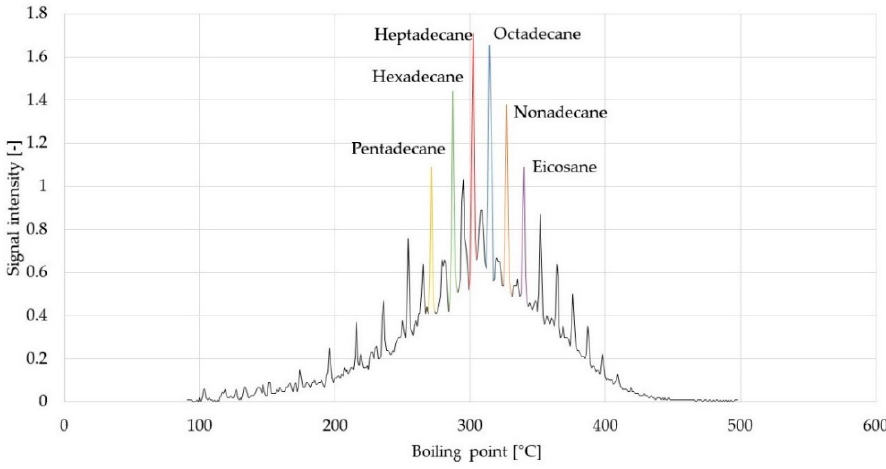
Figure 14. Selected alkanes in average sample after deactivation (first test).